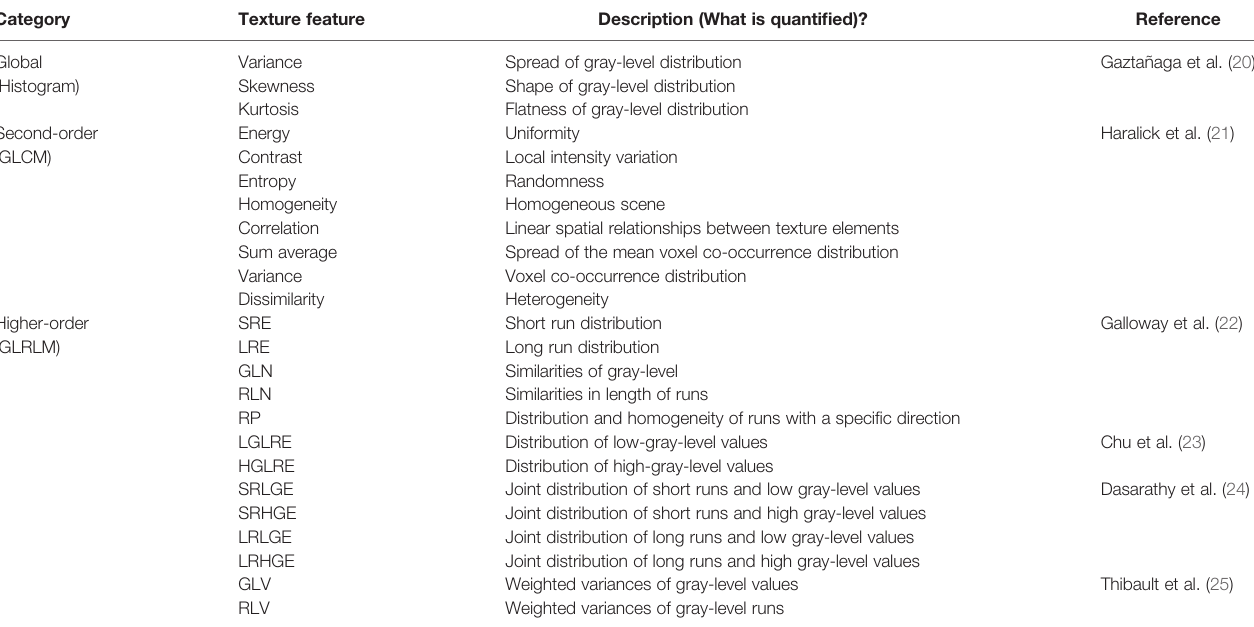
TABLE 1 | Global (histogram-based), gray-level co-occurrence matrix (GLCM)-based, and gray-level run-length matrix (GLRLM)-based texture features and descriptions. Category